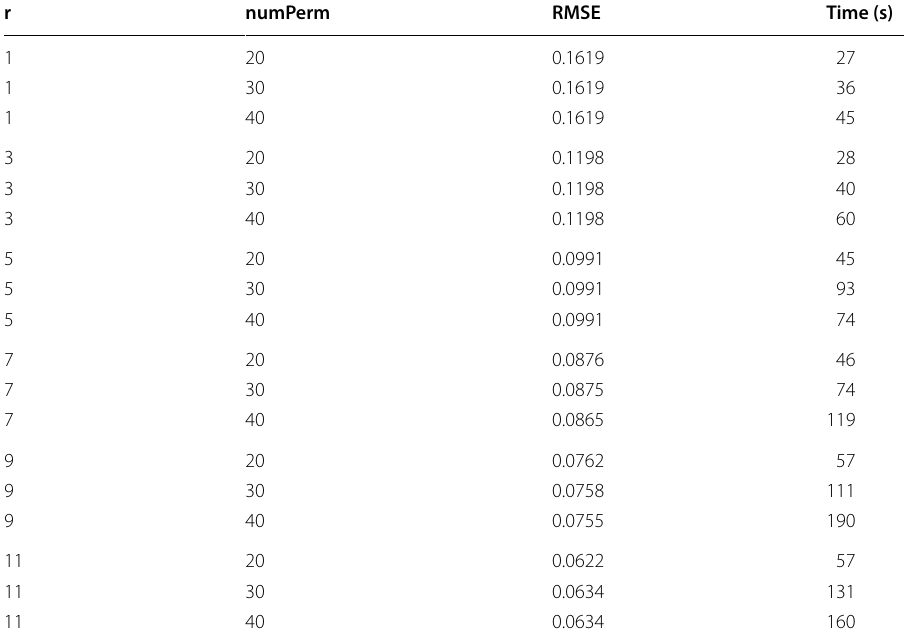
Table 1 Experimental results on LSH showing RMSE and execution time obtained with different configurations of r and